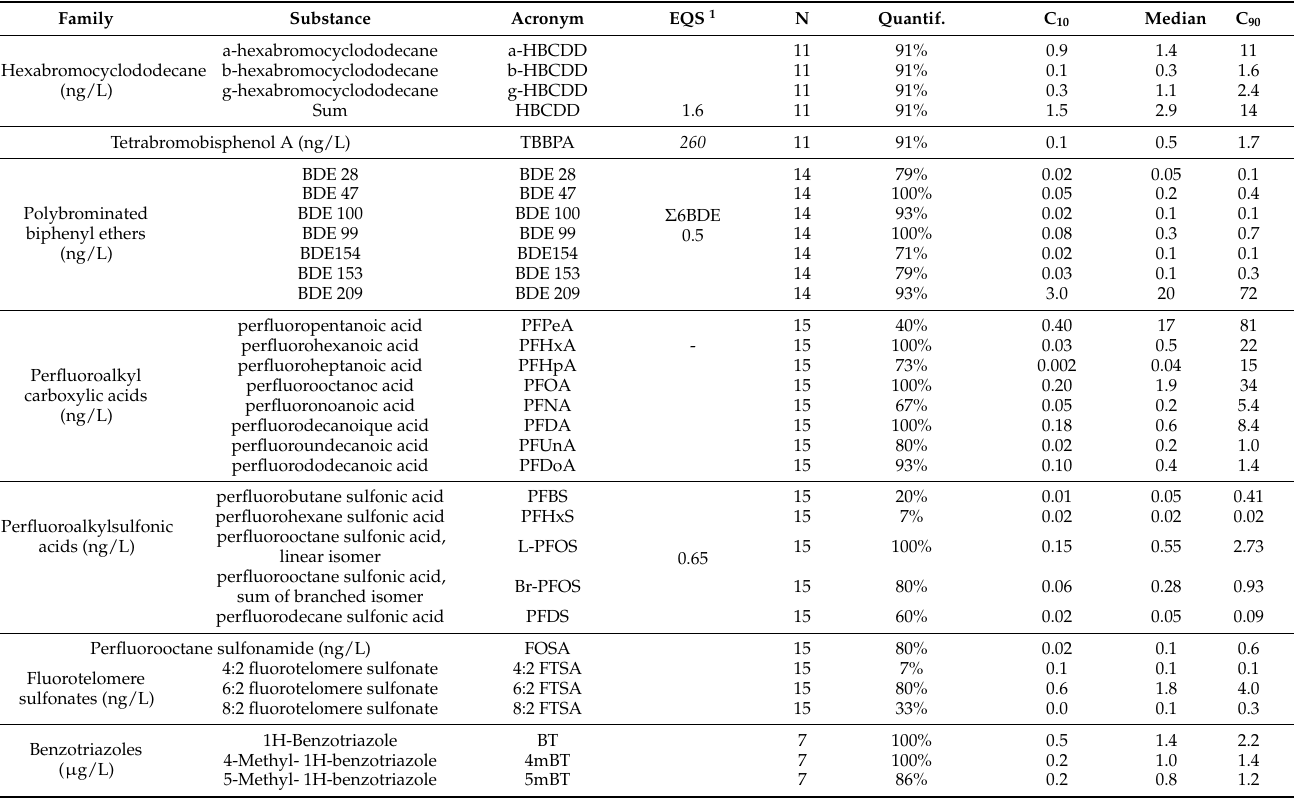
Table 7. Organic micropollutants (groups 4 and 5) analyzed in the runoff, quantification frequency and EMC total